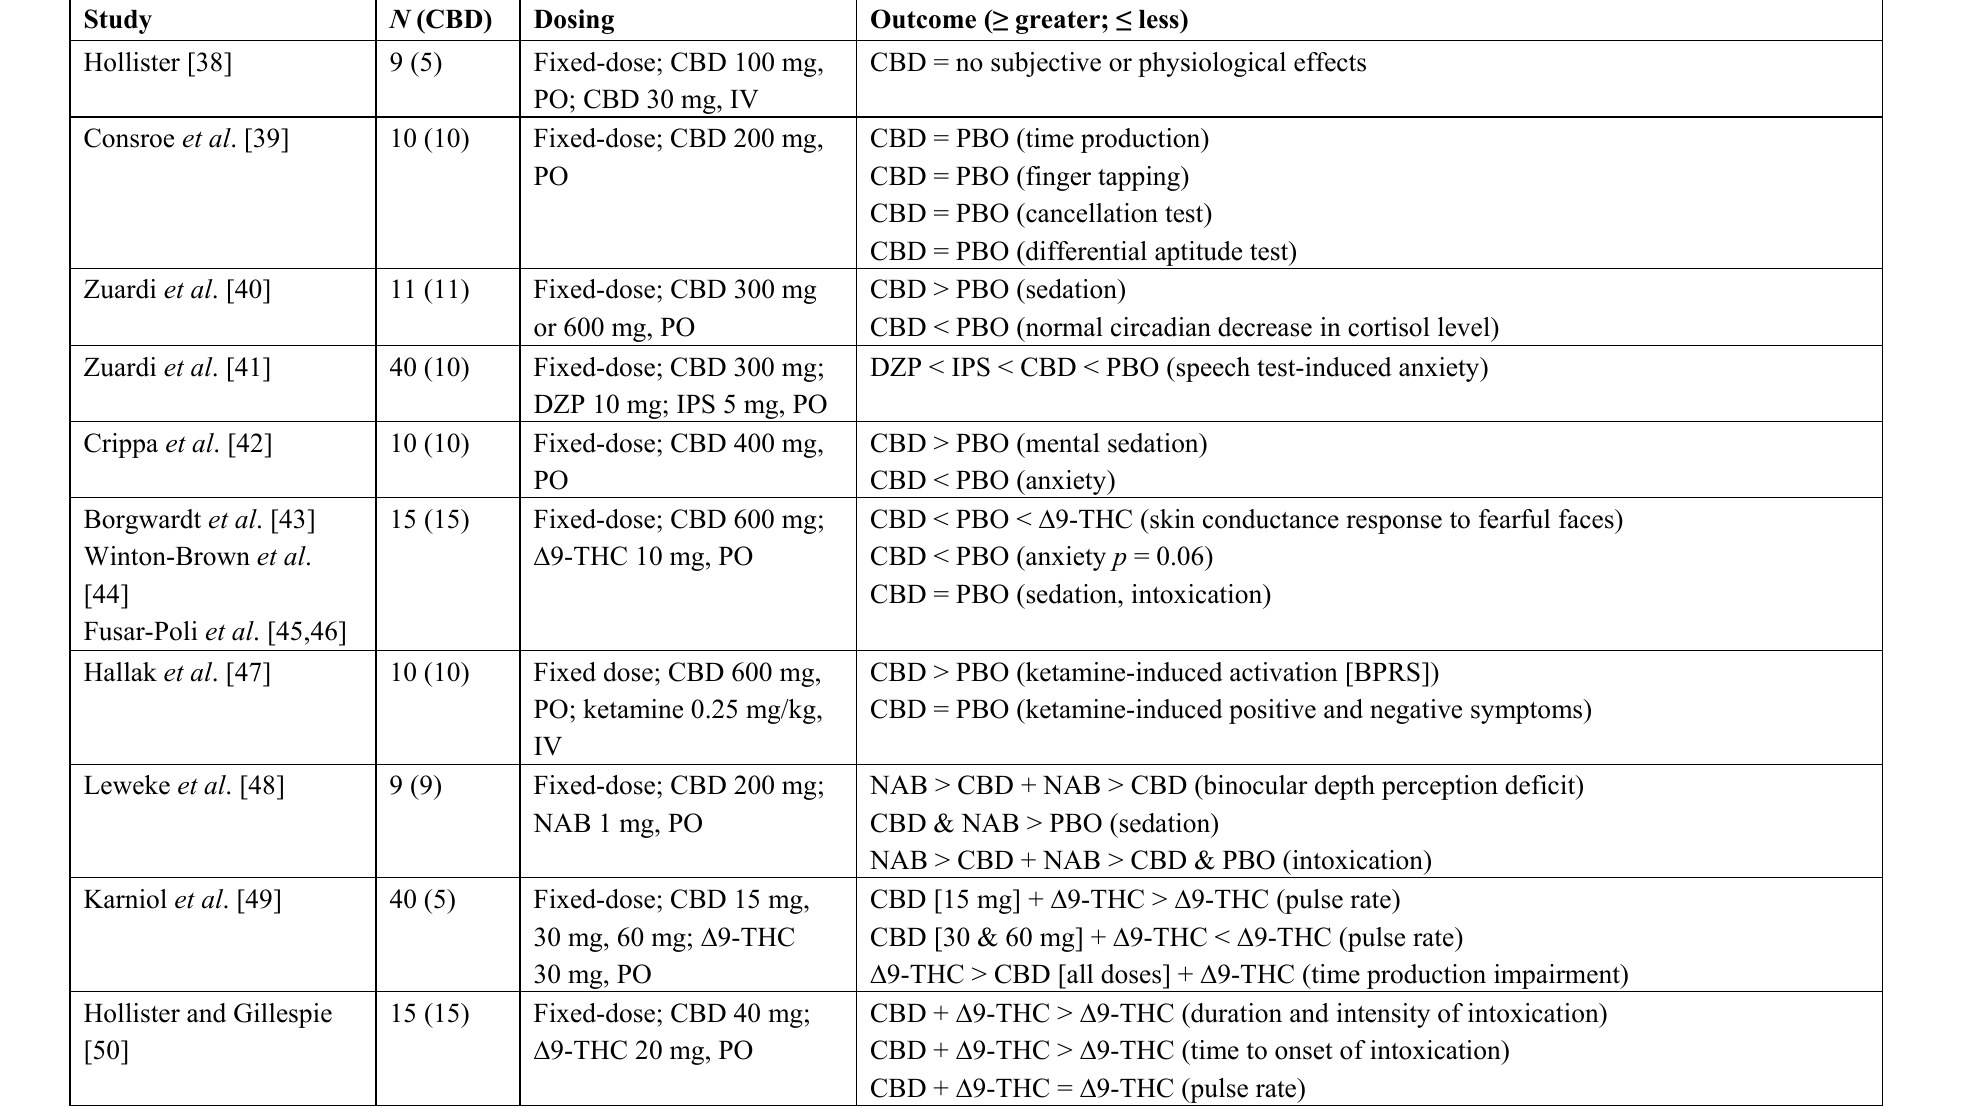
Table 1. Experimental